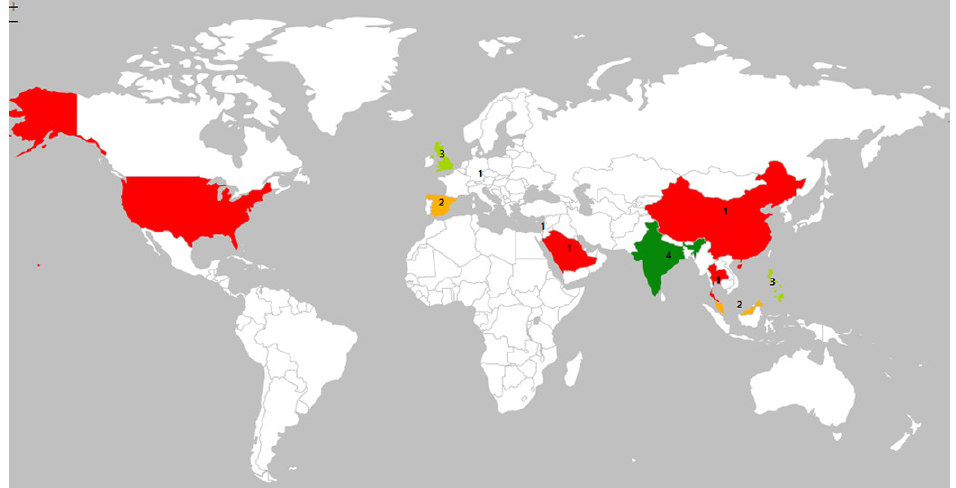
Fig. 3. Total number of reviewed papers by